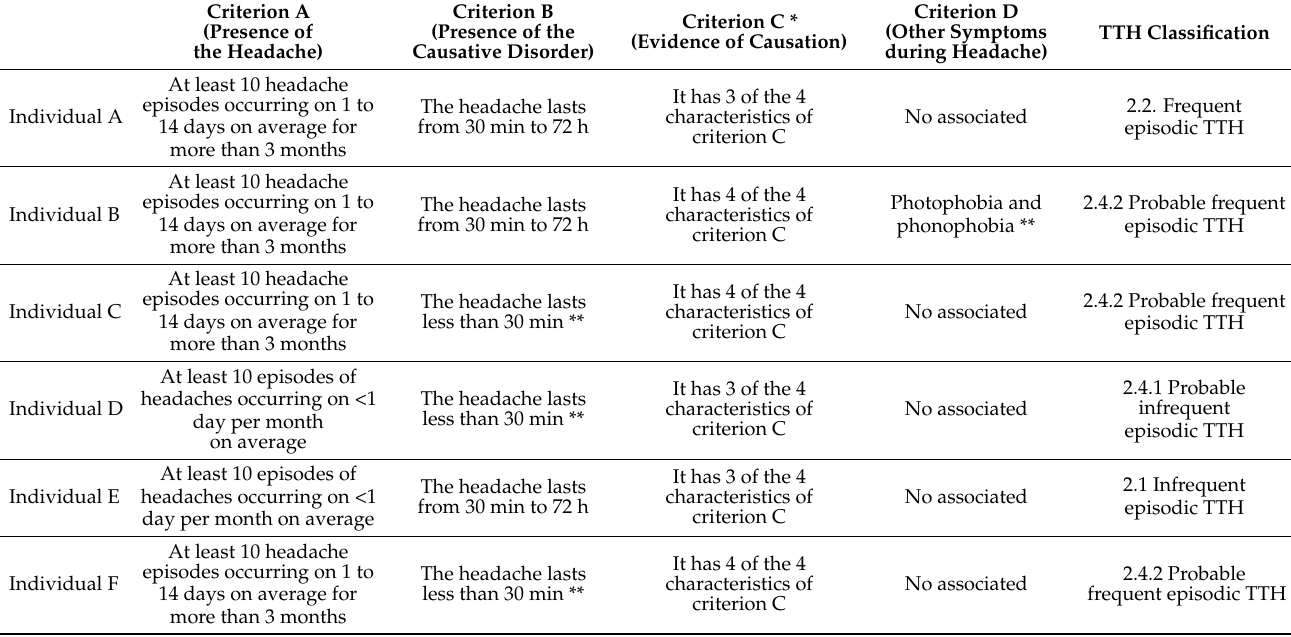
Table 2. Characterization of the sample according to the diagnostic criteria for TTHs of the